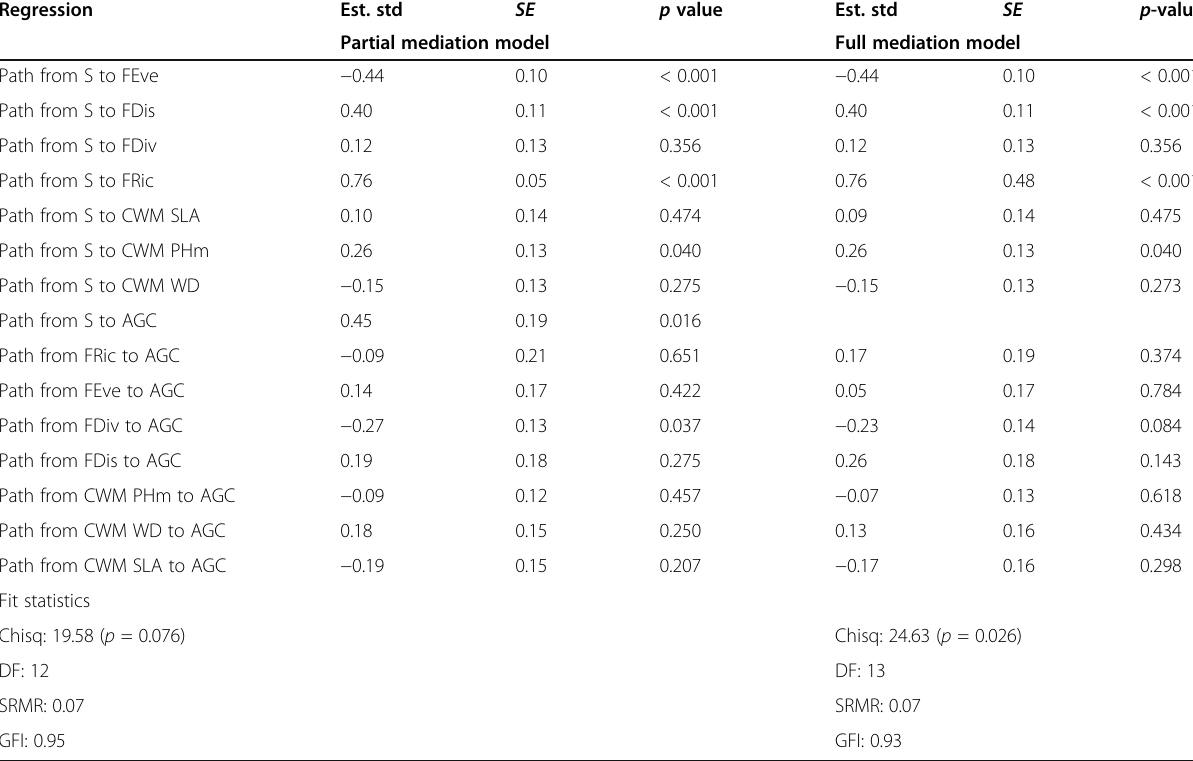
Table 1 Results of the structural equation modeling done to test the effects of species richness on AGC through functional diversity and functional dominance Regression Est. std SE Partial mediation